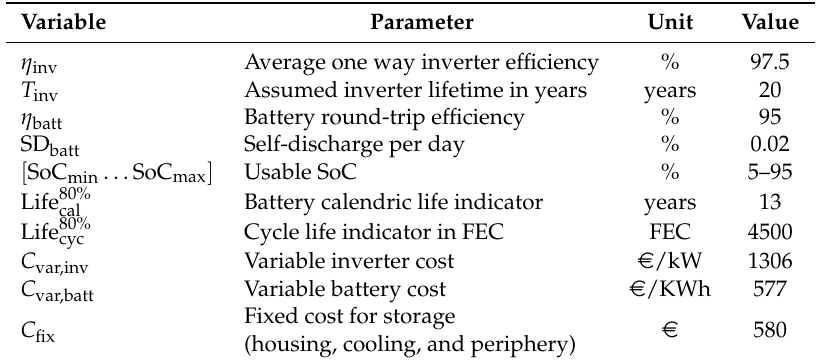
Battery Energy Storage System(BESS)/inverter performance parameters and price information [17].